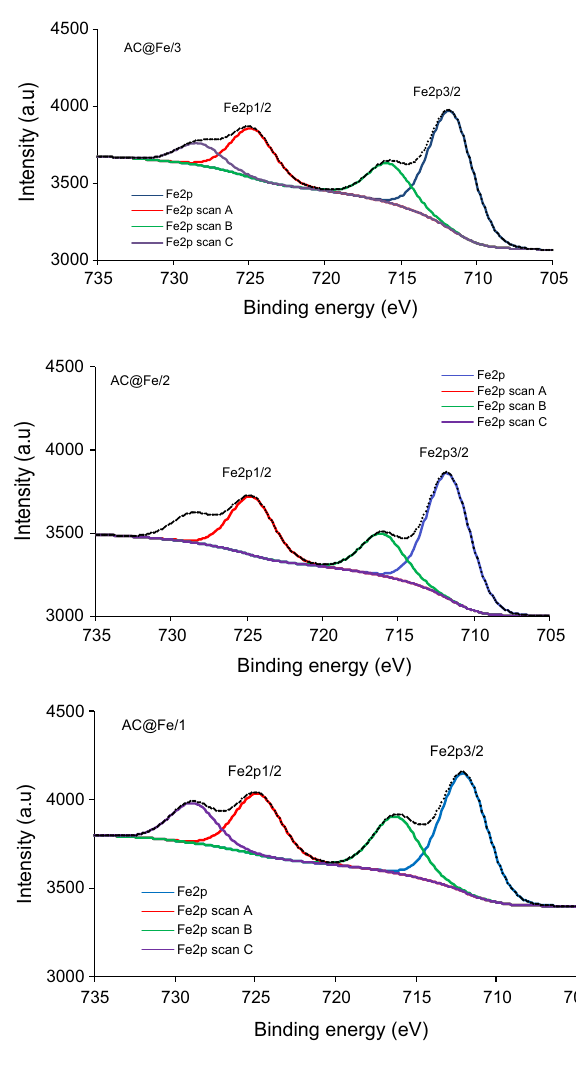
Table 1 XPS analysis results of heterogeneous catalysts and AC showing binding energies of various chemical elements and their content